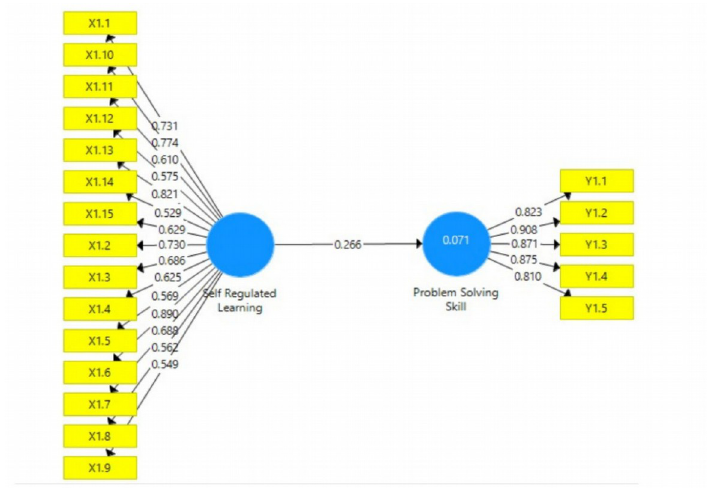
Figure 5. The structural model concept framework Problem-Solving Skill